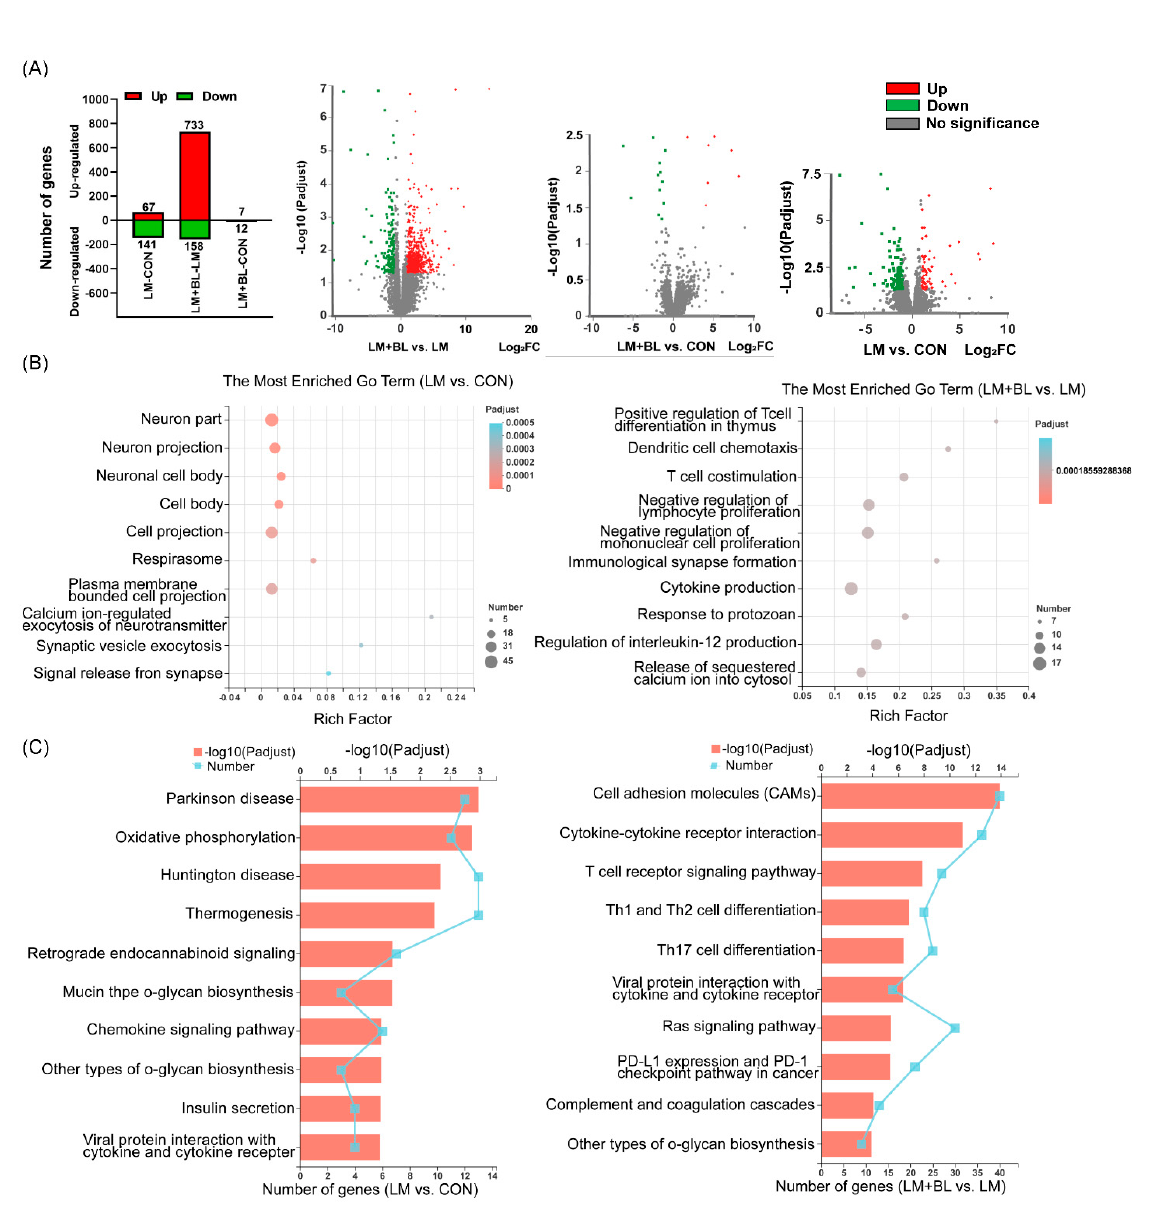
Figure 3. Colon transcriptome. ( A ) Upregulated (red bars) and downregulated (green bars) DEG numbers and volcano plots of identified genes by comparisons between LM + BL and LM, between LM + BL and CON, and between LM and CON ( n = 4 in CON and n = 5 in LM and LM + BL). The p -adjust < 0.05 and absolute fold change ≥ 2 were used as the thresholds to filter the DEGs. Green spots indicate downregulated genes, while red spots indicate upregulated genes and gray ones indicate the genes that are not significant. ( B ) GO function analysis for DEGs in LM vs. CON and in LM + BL vs. LM. ( C ) KEGG pathway enrichment analysis for DEGs in LM vs. CON and in LM + BL vs. LM. The top 10 functions are